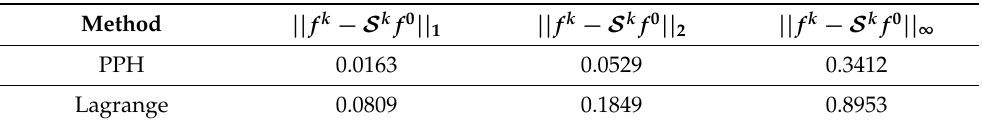
Table 5. Subdivision errors || f k − S k f 0 || p , p = 1,2, ∞ , committed by approximating the original data f k with S k f 0 for k = 5 subdivision levels starting from the initial function point values f 0 at the given grid X 2 with 20 abscissae.